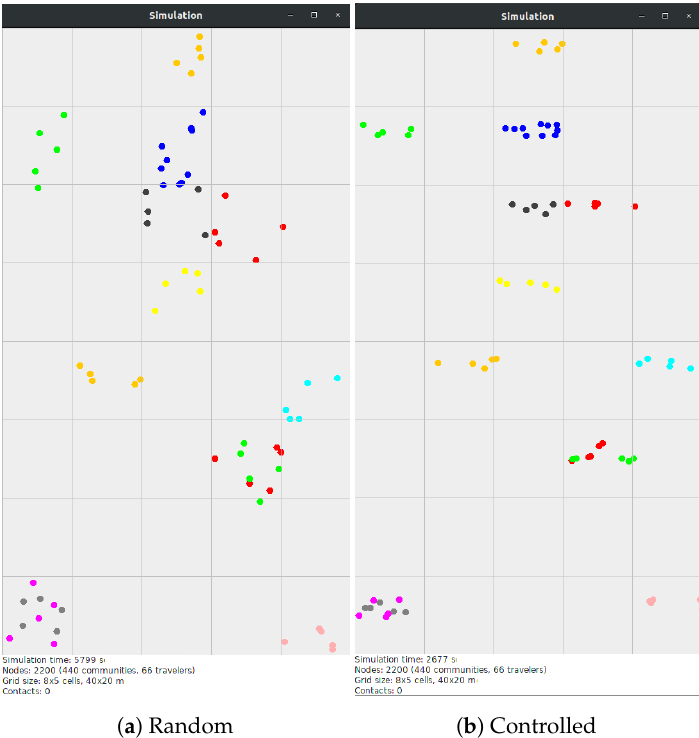
Figure 4. Crowd distribution in FMM (nodes with the same color belong to the same